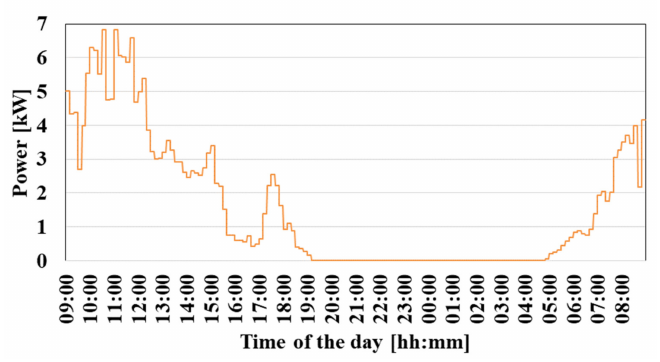
Figure 5. Power generated from common PV system in the residential community.